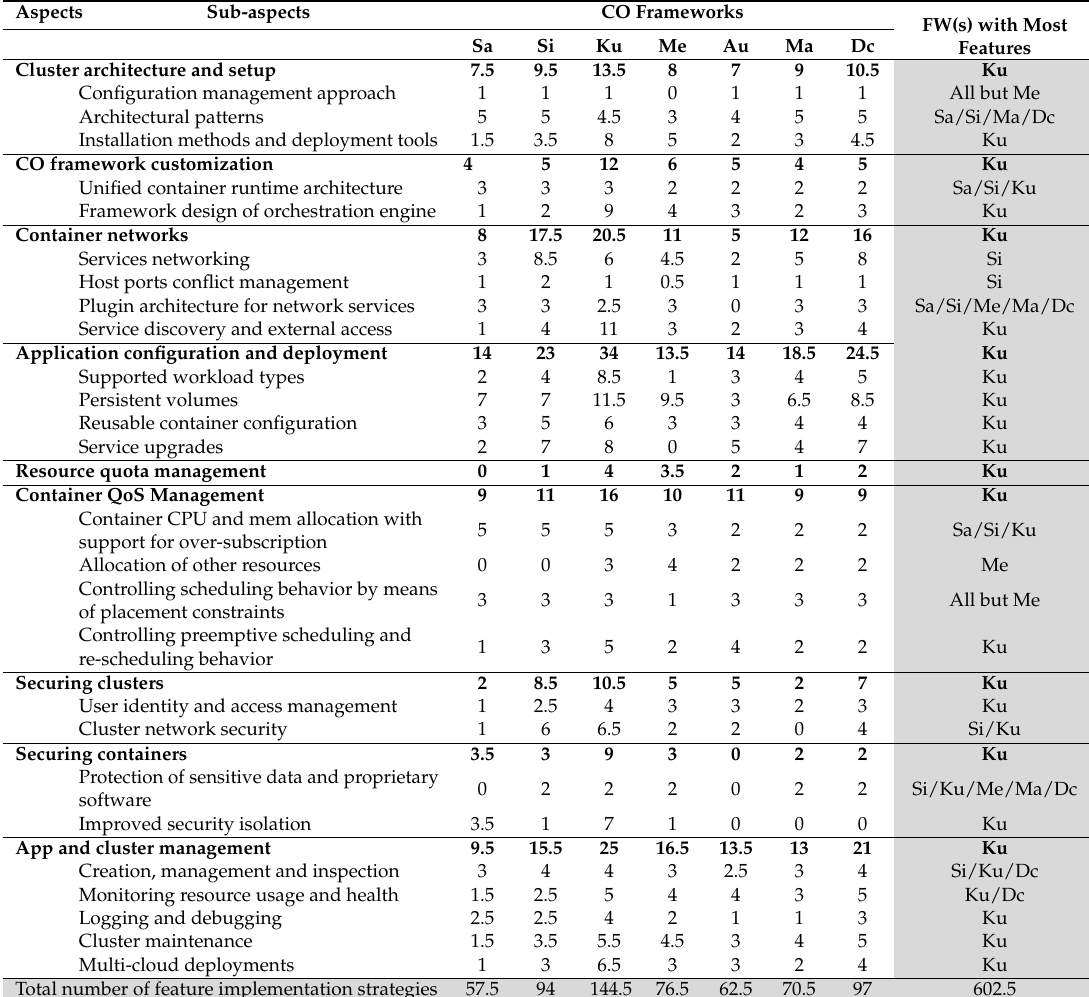
Table 6. Overview of the number of total number of features (i.e., common + unique features) per (sub)-aspect and CO framework. The last column also shows which framework(s) support(s) the highest number of features per